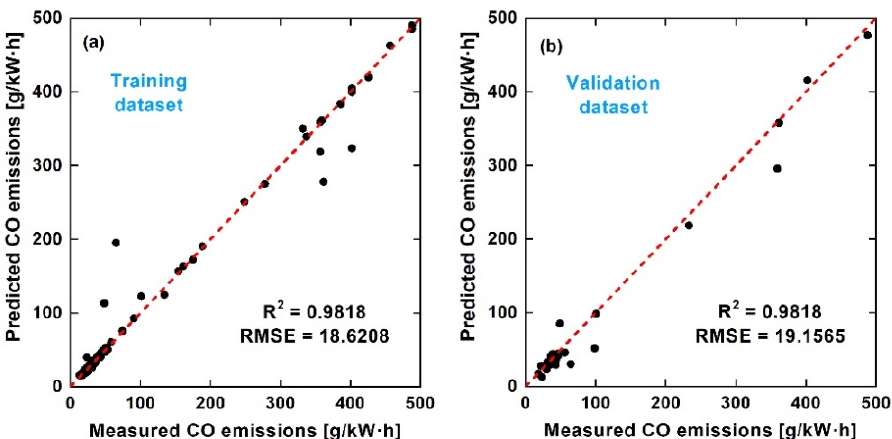
Figure 7. Comparison of SVR predicted results with measured data of CO emissions. ( a ) Training dataset; ( b ) Validation dataset.